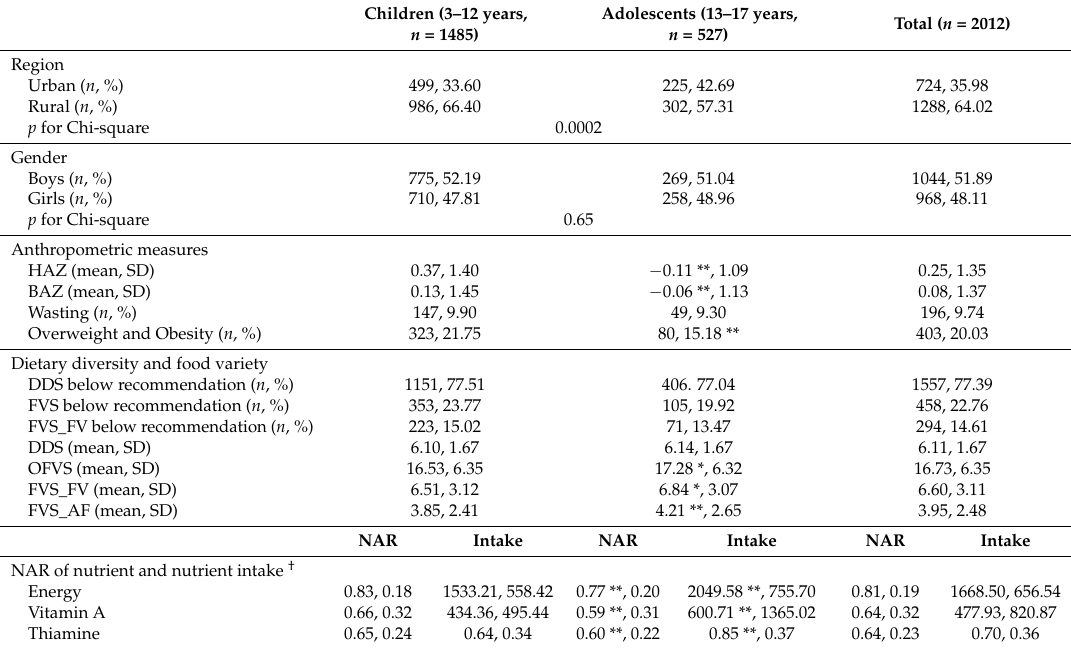
Table 1. Basic characteristics of the study population